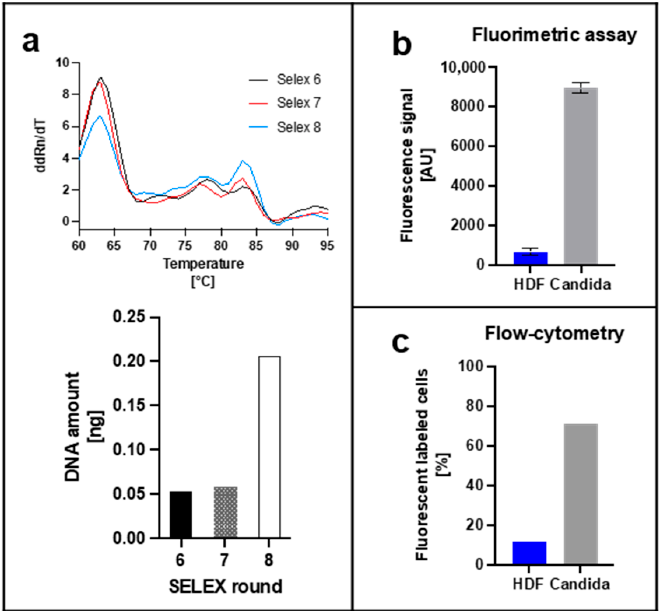
Figure 2. Evolution and specific labeling of mixed Candida cells by the SELEX-derived aptamer library R8. ( a ) Real-time PCR based analysis of melting curves of the round six to eight aptamer libraries (upper panel) and DNA concentrations in eluates immediately after the SELEX rounds (lower panel). P1 and P2 are the two major temperature peaks observed in the experiments. ( b ) Identification of Candida by fluorometric assays. HDF cells and Candida were incubated with aptamer and compared by fluorescence measurement. ( c ) Specific identification of Candida by flow cytometry. Incubation of cells together with aptamer followed by flow-cytometry analysis.